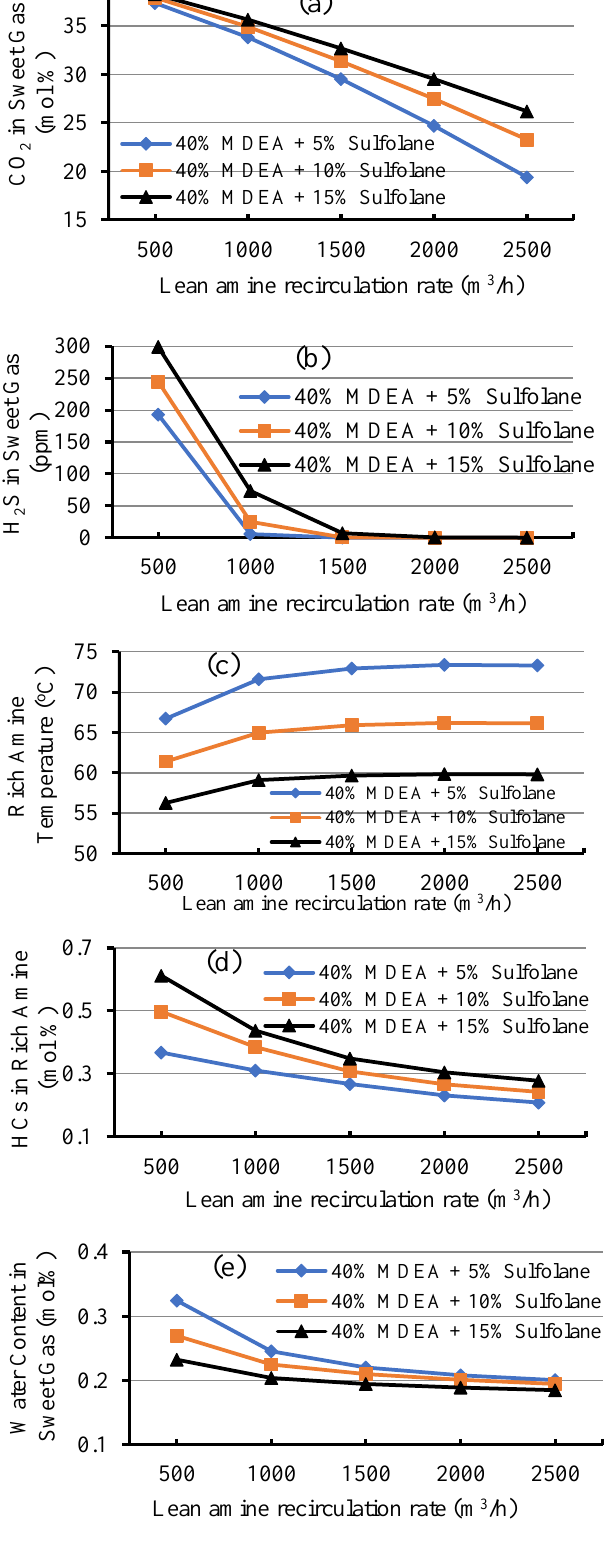
Fig. 7. Amine Absorber performance with increasing recirculation rate with 40 mol% MDEA and 5-10-15 mol% Sulfolane in aqueous solution at pressure drop of 34 kPa and 24